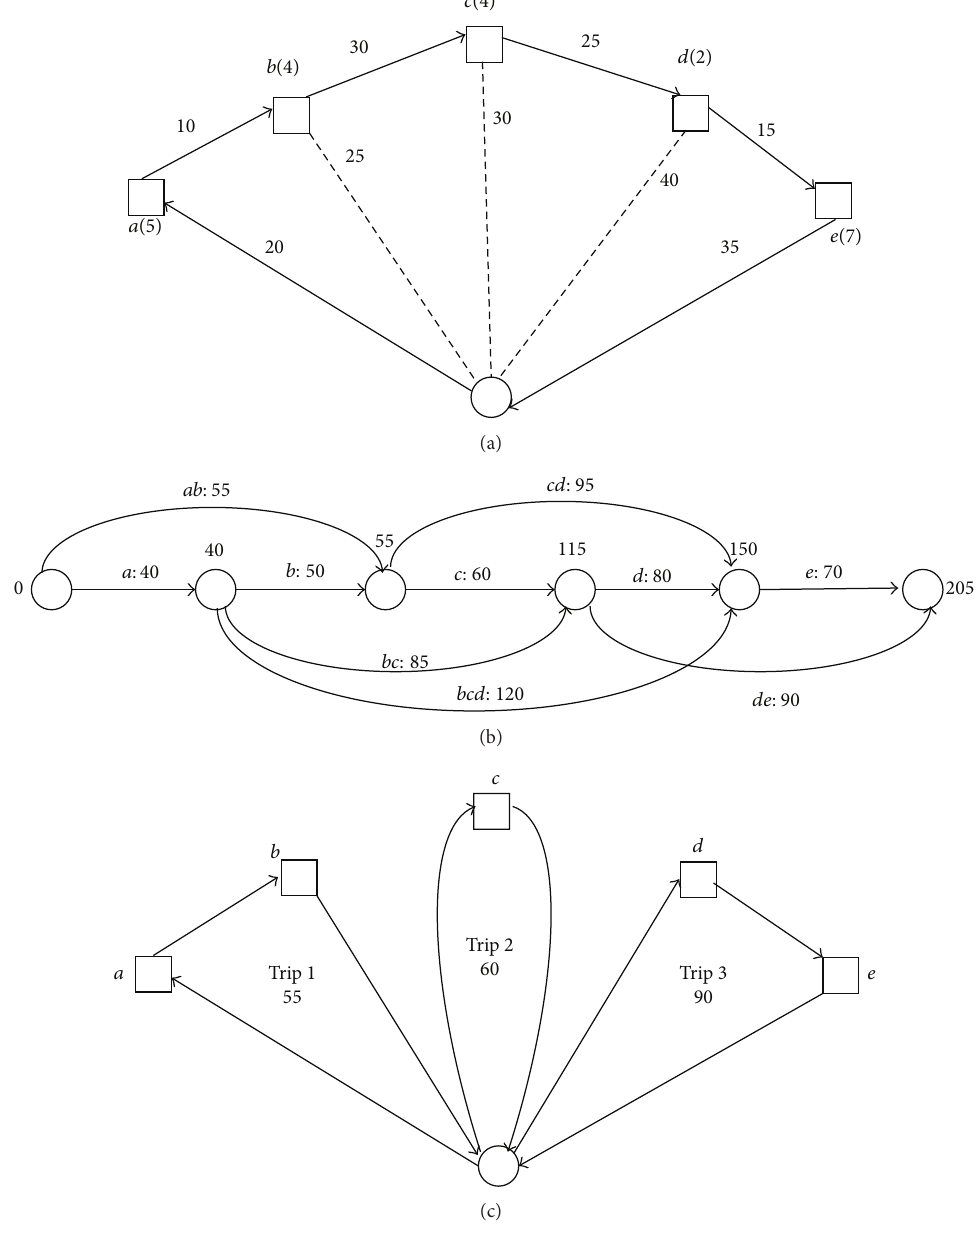
Figure 4: Example of Split procedure